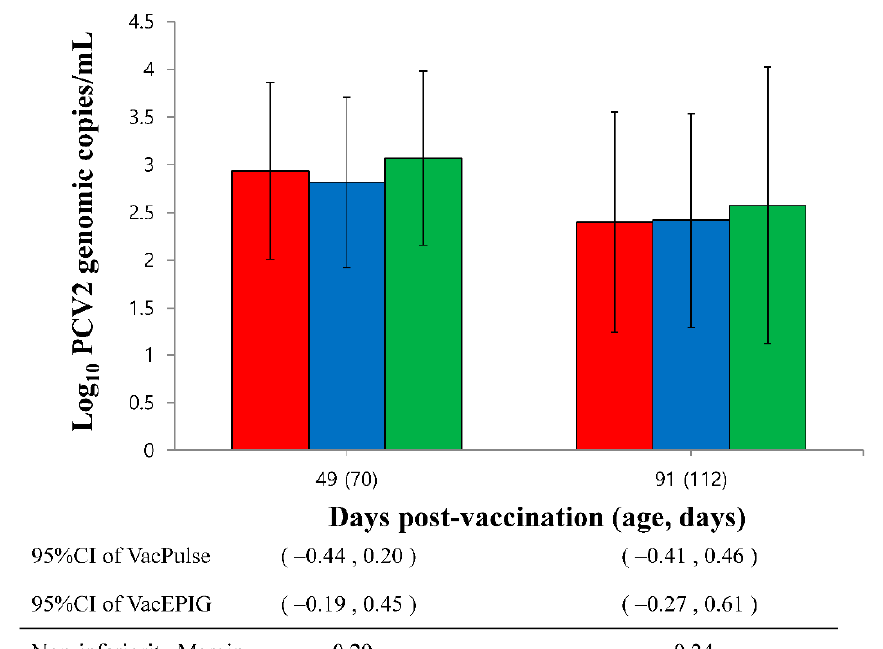
Figure 3. The upper bound of the 95% confidence intervals (CI) on the difference in PCV2d load in serum in the needle ‐ free device (VacPulse, ● ) group at 49 days post ‐ vaccination (dpv) showed non ‐ inferiority to conventional needle ‐ syringe (VacS, ● ) group. The PCV2d loads in serum of nee ‐ dle ‐ free device (VacEPIC, ● ) group at 49 and 91 dpv did not show non ‐ inferiority to conventional needle ‐ syringe (VacS, ● )